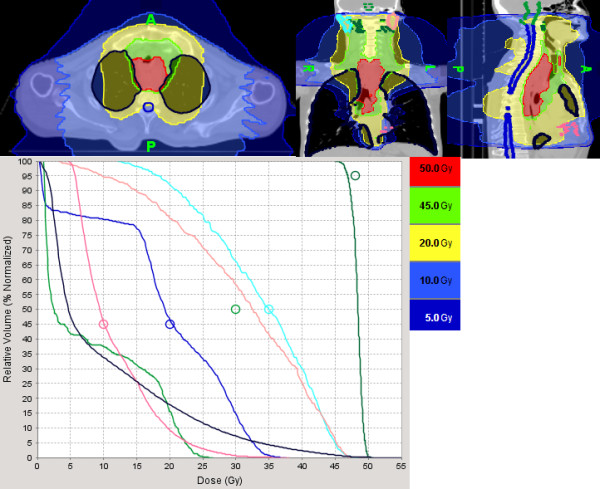
Illustration of the dose-volume histogram of tomotherapy planning for a patient with a T4N1M0 squamous cell carcinoma extending from the cricoid cartilage to the lower third of the esophagus. The cervical, mediastinal, and celiac lymph nodes were treated to 45 Gy in 180 Gy/fraction while the gross tumor was treated with an integrated boost technique to 50 Gy in 2 Gy/fraction. The black line illustrates the total lung dose. Despite the large tumor size, the volume of lungs treated to 20 Gy (V20), 15 Gy (V15), 10 Gy (V10) and 5 Gy (V5) was 18%, 25%, 38%, and 50%, respectively. Maximum spinal cord dose and brain stem dose was 37 Gy (dark blue line) and 27 Gy (light green), respectively. The pink line illustrates the radiation dose to the cardiac ventricles. The blue and light maroon line illustrates the dose to the right and left parotid respectively.